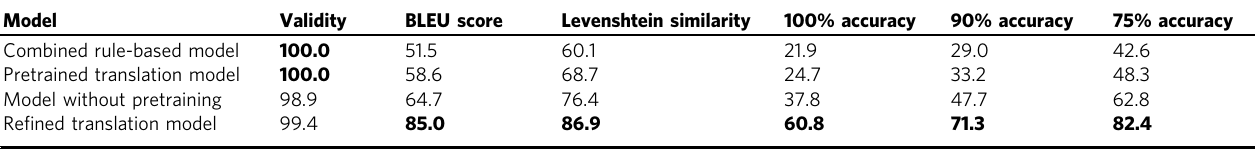
Table 3 Metrics for the extraction of synthesis